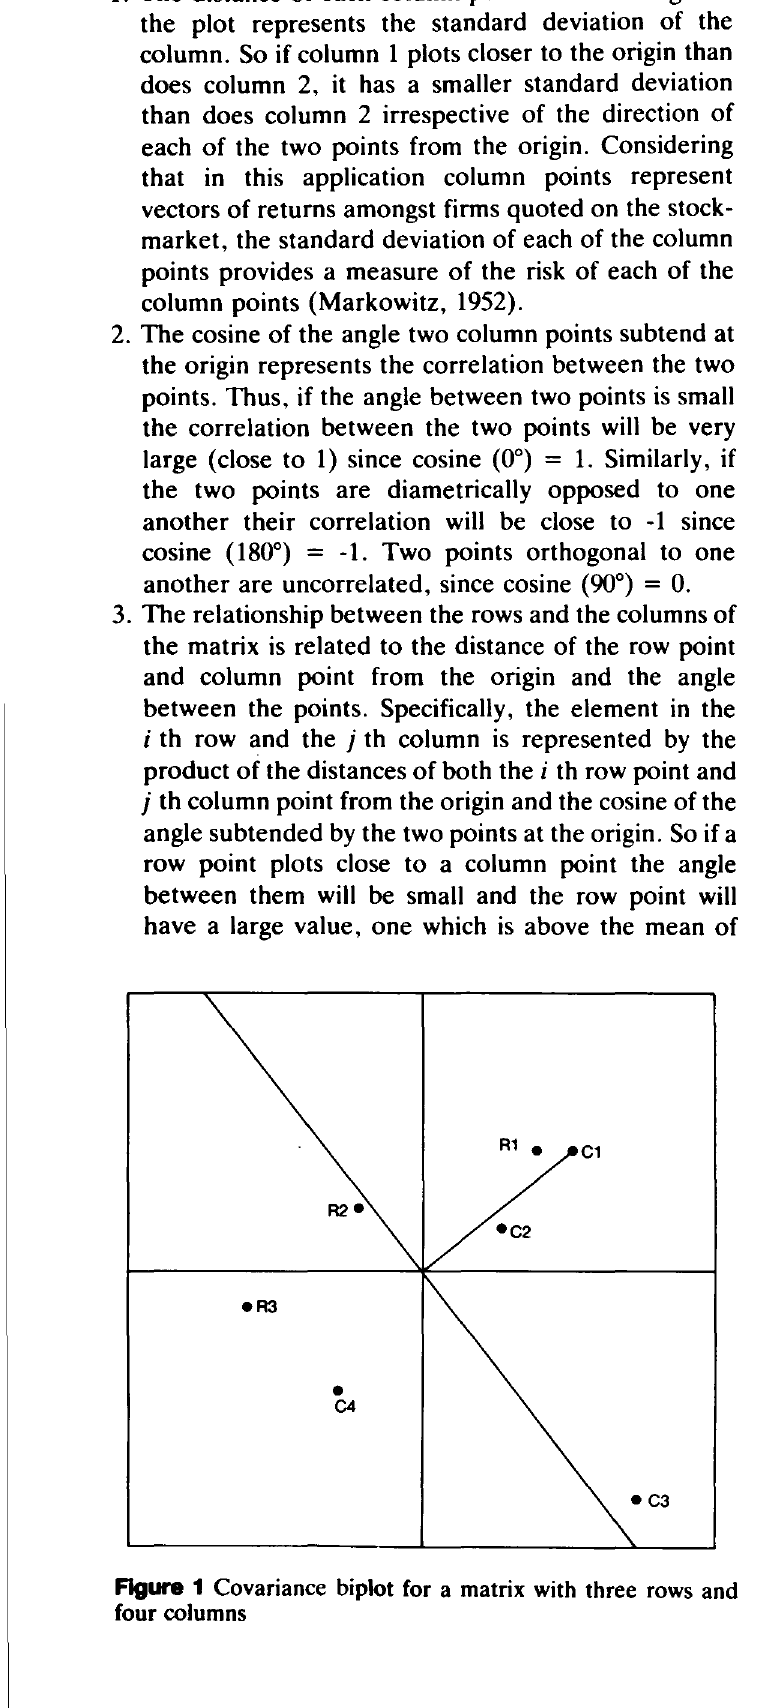
Figure 1 Covariance biplot for a matrix with three rows and four